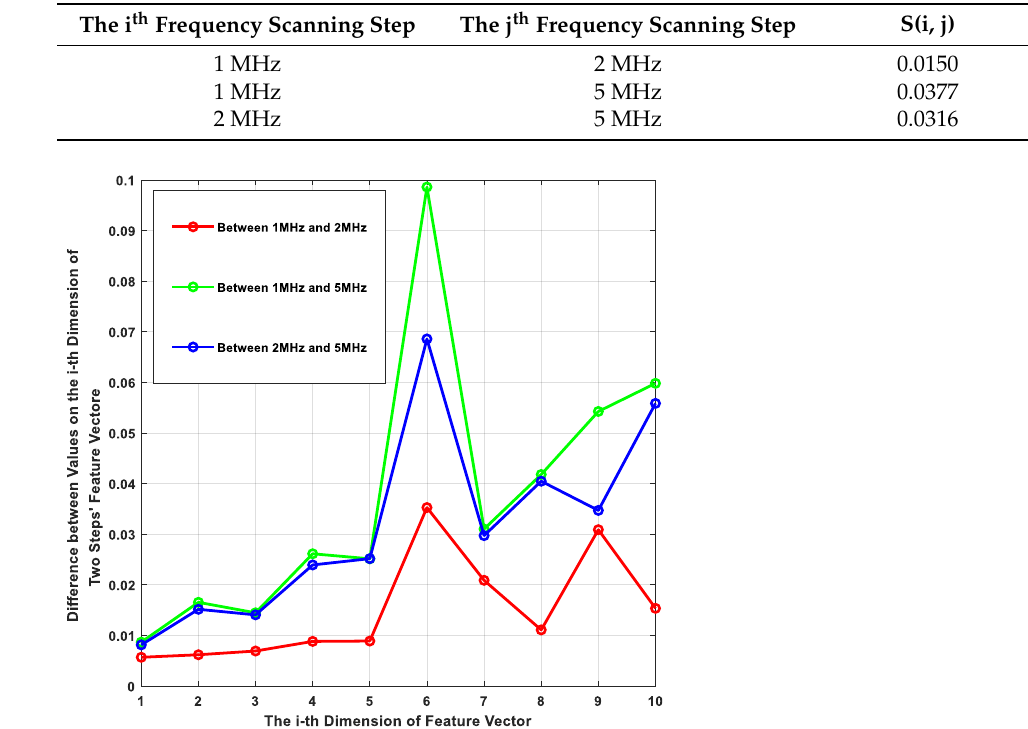
Table 5. There is similarity between different frequency scanning steps. S(i, j) is calculated using Figure 7. Adaptability of different steps for the FNN with PCA. Equation (15), and there is similarity between the i th frequency scanning step and the j th frequency Table 4. MAEs of different frequency scanning steps. scanning step.